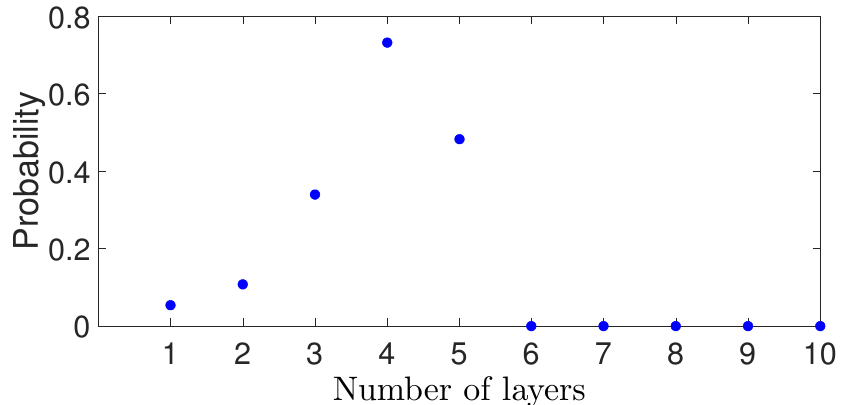
Figure 17. Probability of closed-loop stability vs. RNN